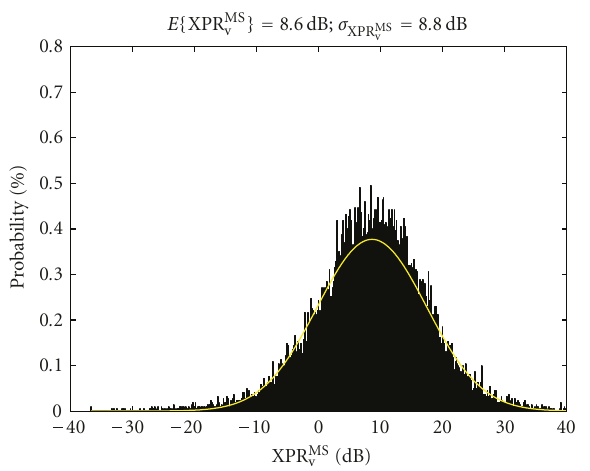
Figure 14: PDF of the XPR MS Rx27.